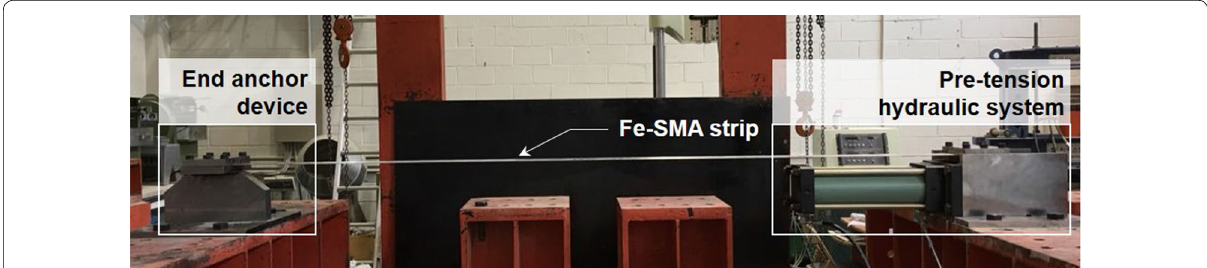
Fig. 5 Overview of the pre-straining